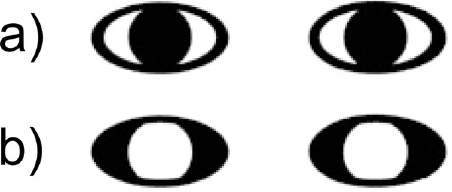
Figure 3. Central cue in the natural-contrast condition ( a ) and the reversed-contrast condition ( b ).